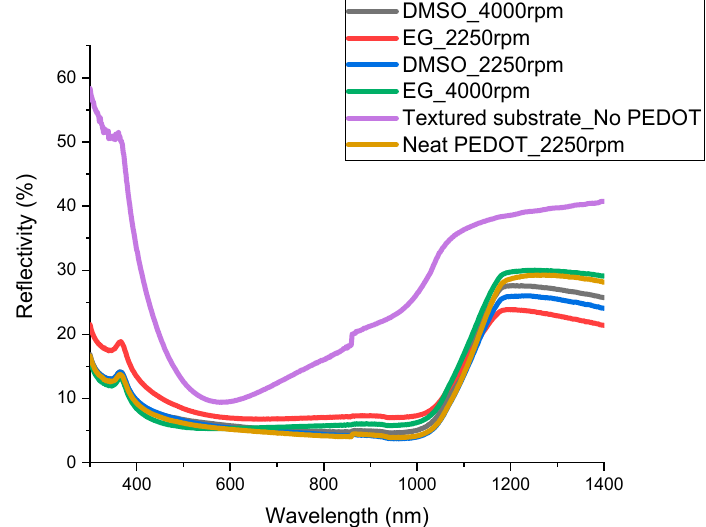
Figure 4. The reflectivity of PEDOT:PSS films on textured Si substrates.